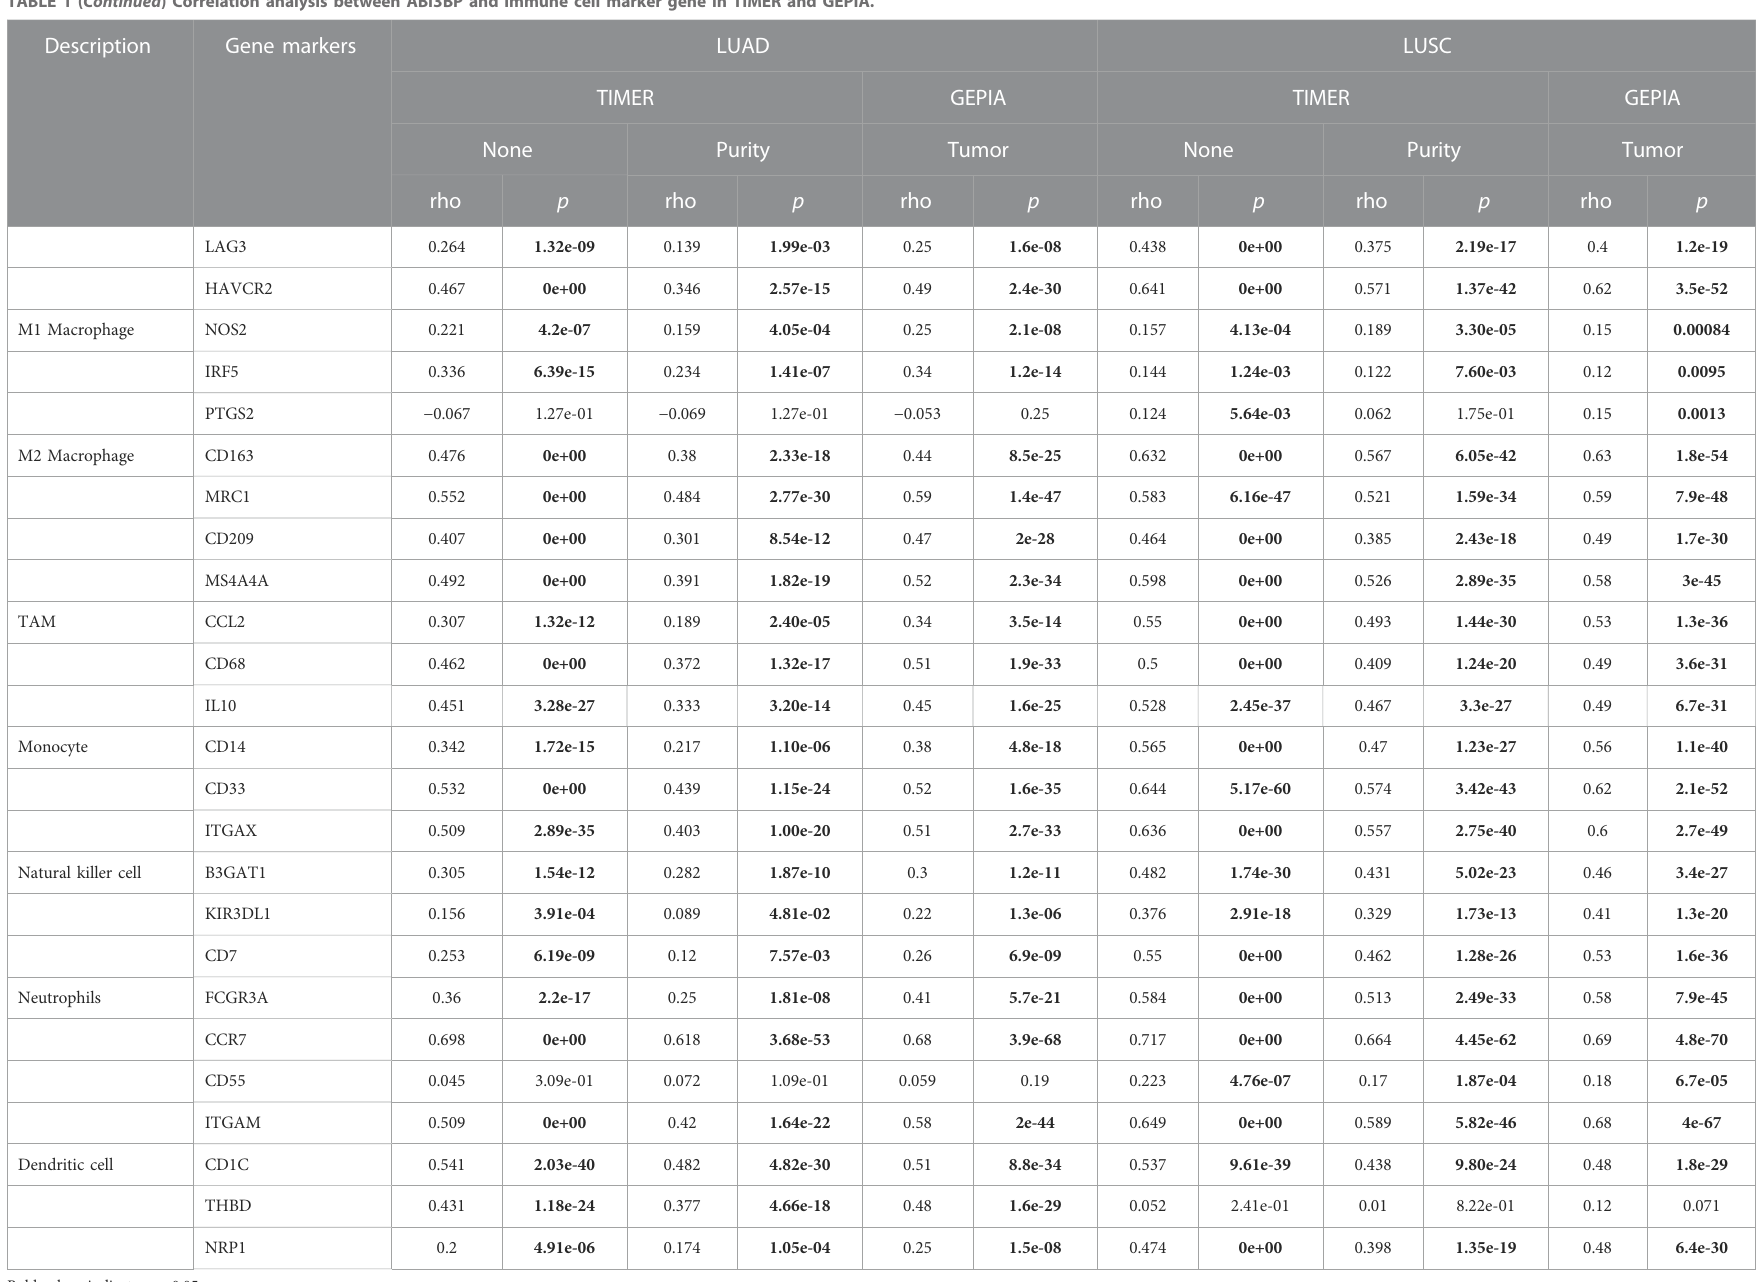
Bold values indicate p <